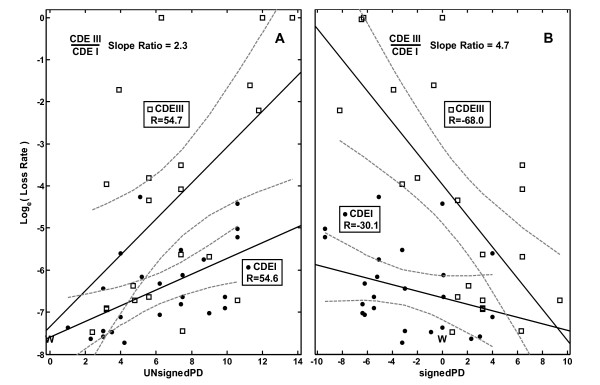
Regression plots of chromosome loss rates vs PD changes for CDEI & CDEIII single mutants. Scatter plots and regression lines for core binding sequences showing steeper slopes for CDEIII (open squares) as compared to CDEI (solid circles) for both (A) unsignedPD and (B) signedPD. Correlation values, R, are shown within text boxes. The position of the wild type data point is plotted as a 'W'. Dashed lines show 95% confidence intervals for average predicted values.